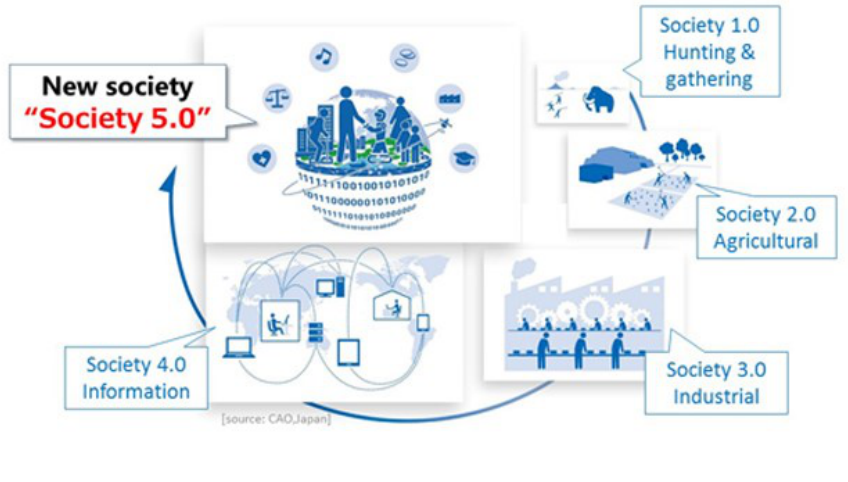
Figure 1. New Society 5.0 [1].